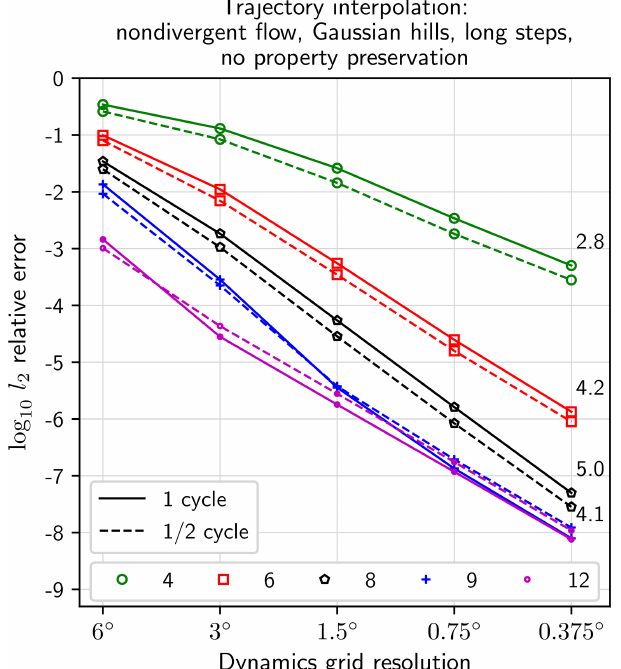
Figure 3. Comparison of relative errors calculated at the test simu- lation’s midpoint time of 6d (1 / 2 cycle, dashed lines) and endpoint time of 12d (1 cycle, solid lines). Each number at the right side of the plot is the empirical OOA computed using the final two points of the one-cycle result.